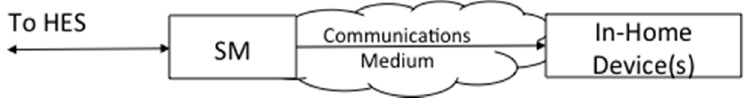
Figure 3. Architecture 1: the SM directly sends the data to the In-Home Devices